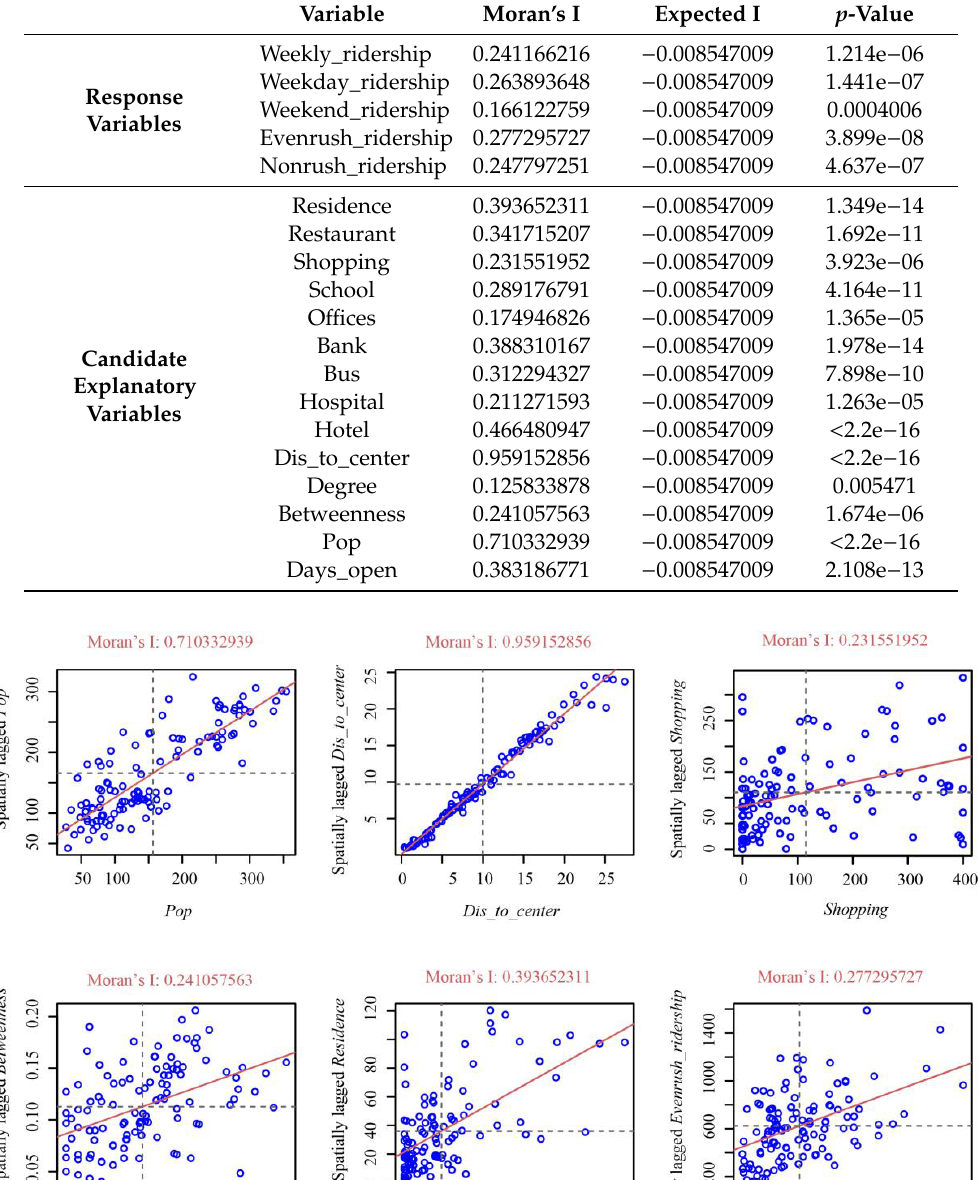
Table 3. Moran’s I test for spatial autocorrelation of all variables.